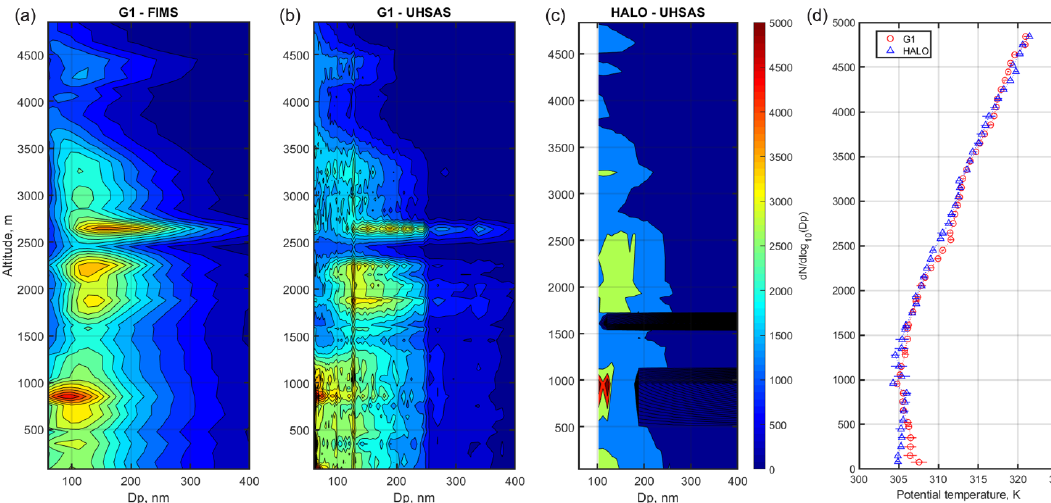
Figure 10. Aerosol size distribution vertical profiles measured by (a) the G1 FIMS, (b) the G1 UHSAS, and (c) the HALO UHSAS, and (d) potential temperature aboard the G1 and HALO on 21 September.